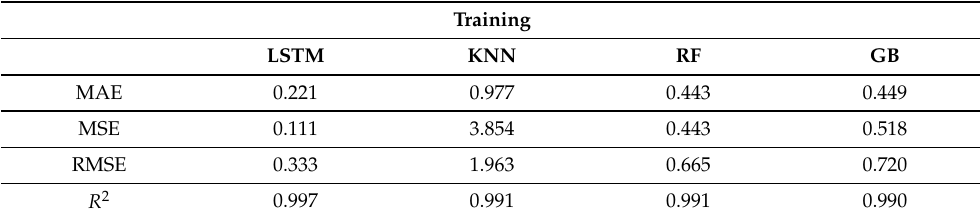
Table 4. Training errors of the RF, KNN, LSTM, and GB models for estimating tilt angle of acceptance for solar energy, with error measured in the degree unit of the target variable.